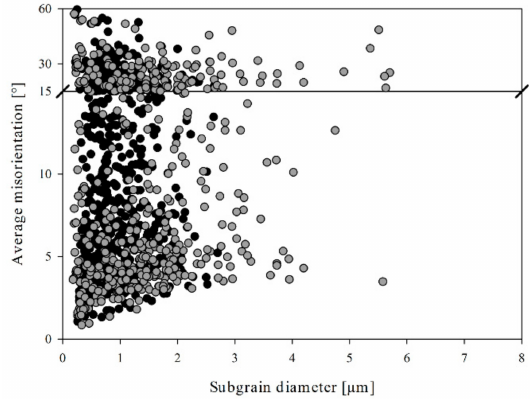
Figure 9. Average misorientation of individual subgrains and grains plotted against mean equivalent circle diameter for subgrains in CP Al with several orientations after deformation (black points) and after 10 5 s annealing at 250 ◦ C (grey